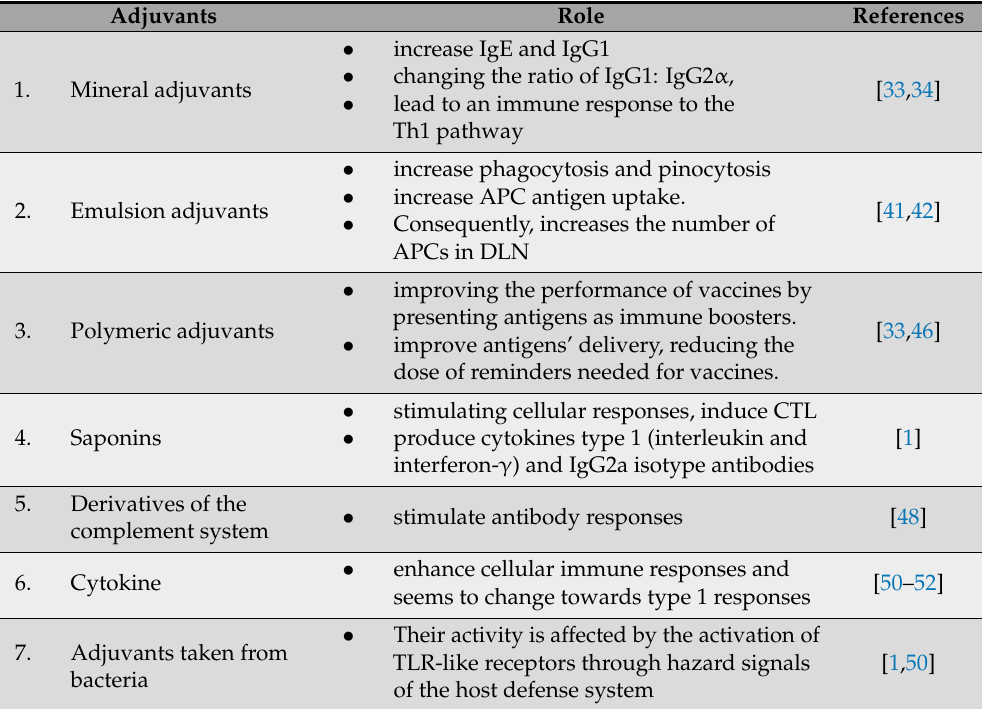
Table 1. Types of adjuvants and their